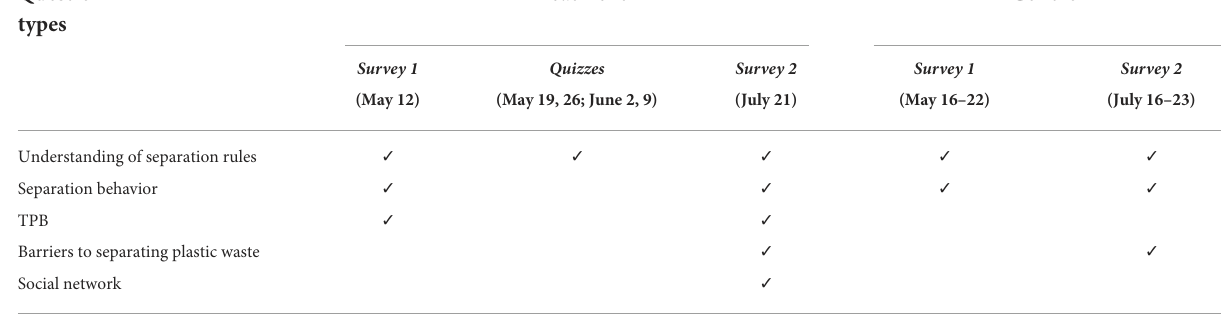
TABLE 2 Key components and schedule of surveys/quizzes by